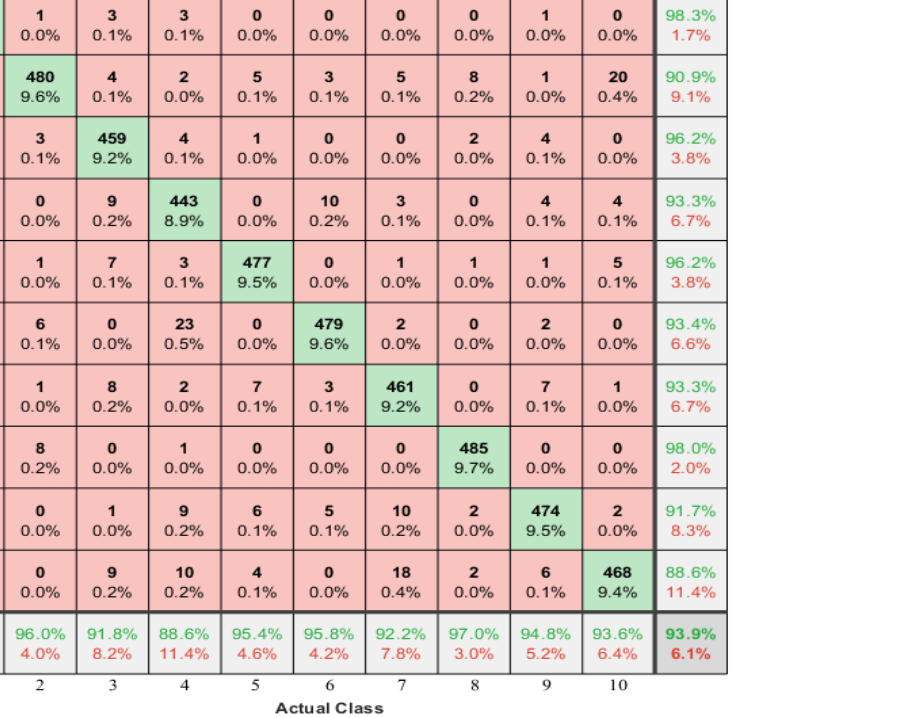
Figure 8. Confusion Matrix of 10 Users.